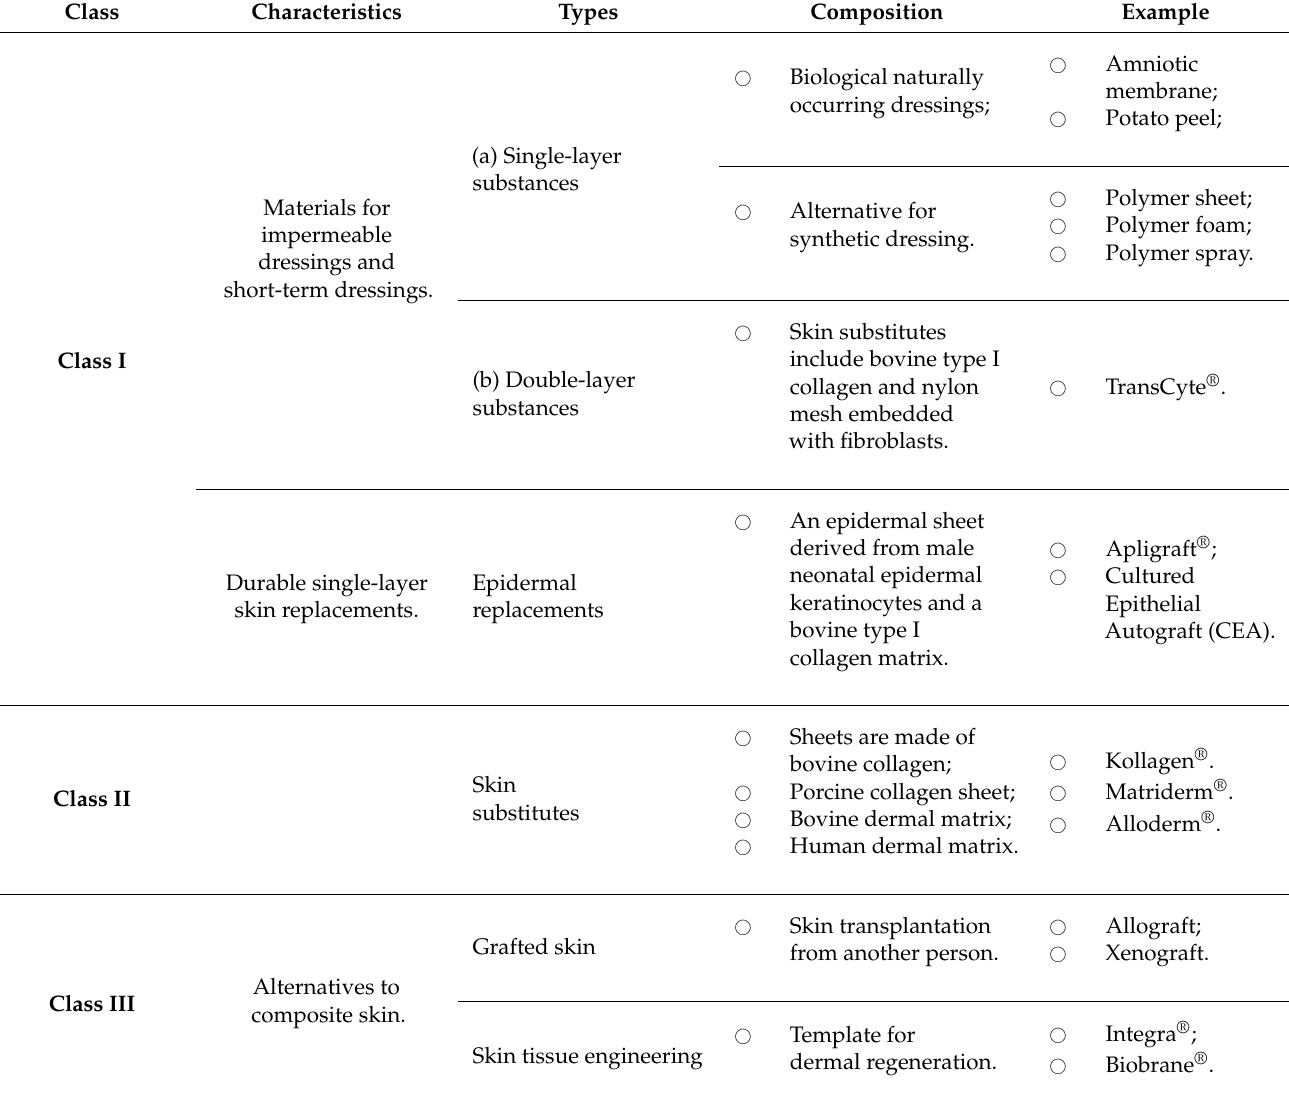
Table 2. Classification of biological and synthetic skin